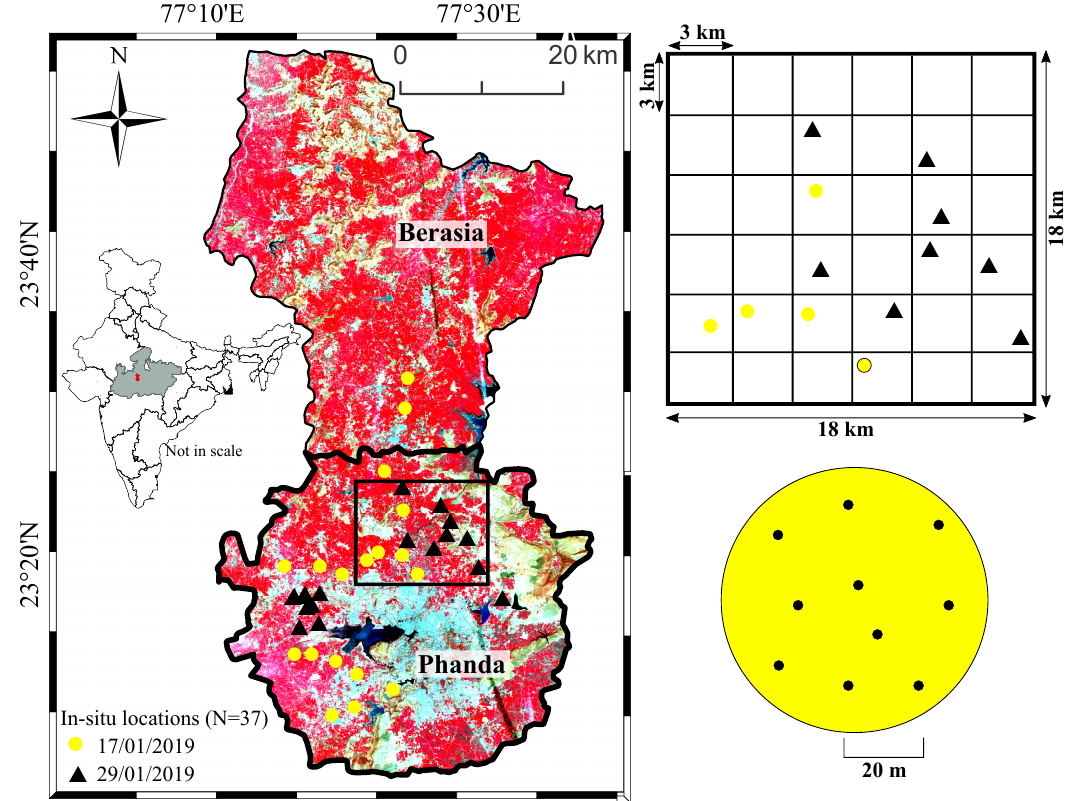
Figure 1. Landsat-8 image in False Color Composite (FCC) shows the administrative blocks (Phanda and Berasia) of Bhopal district, Madhya Pradesh. Circles in Yellow and triangles in black are the locations of soil moisture measurement in the field. Grid on the top right illustrates the random sampling strategy to collect soil